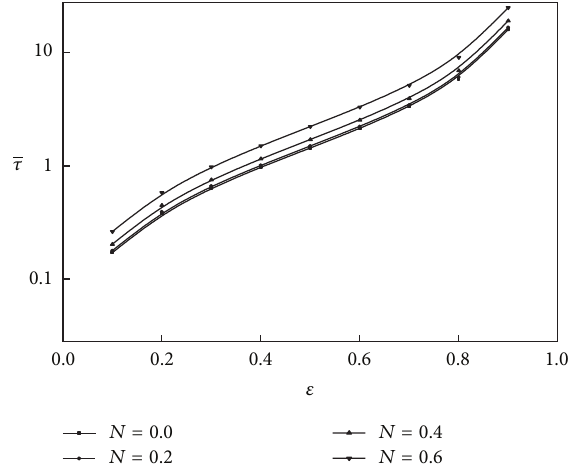
Figure 8: Varition of nondimensional time 𝜏 with eccentricity ratio 𝜀 for different values of 𝑁 with 𝑙 = 0.4 , 𝑄 = 0.5 , and 𝜆 = 0.5 .